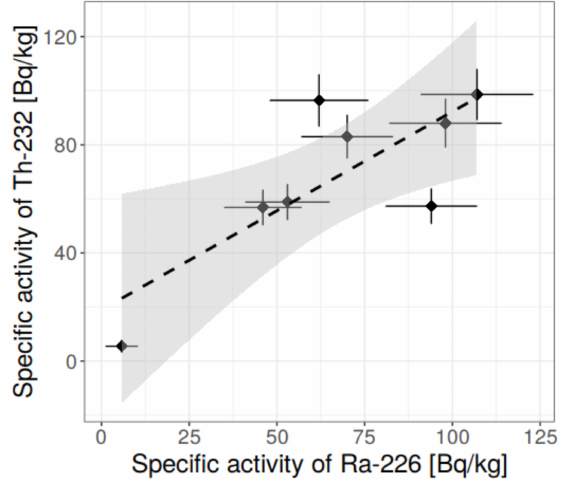
Figure 16. Relationship between specific activity concentration of 232 Th and 226 Ra in measured granite samples, taking into account the rejection of outliers. Clearly visible linear dependency. Fitted line is shown with 95% confidence corridor for a and b coe ffi cients in the linear